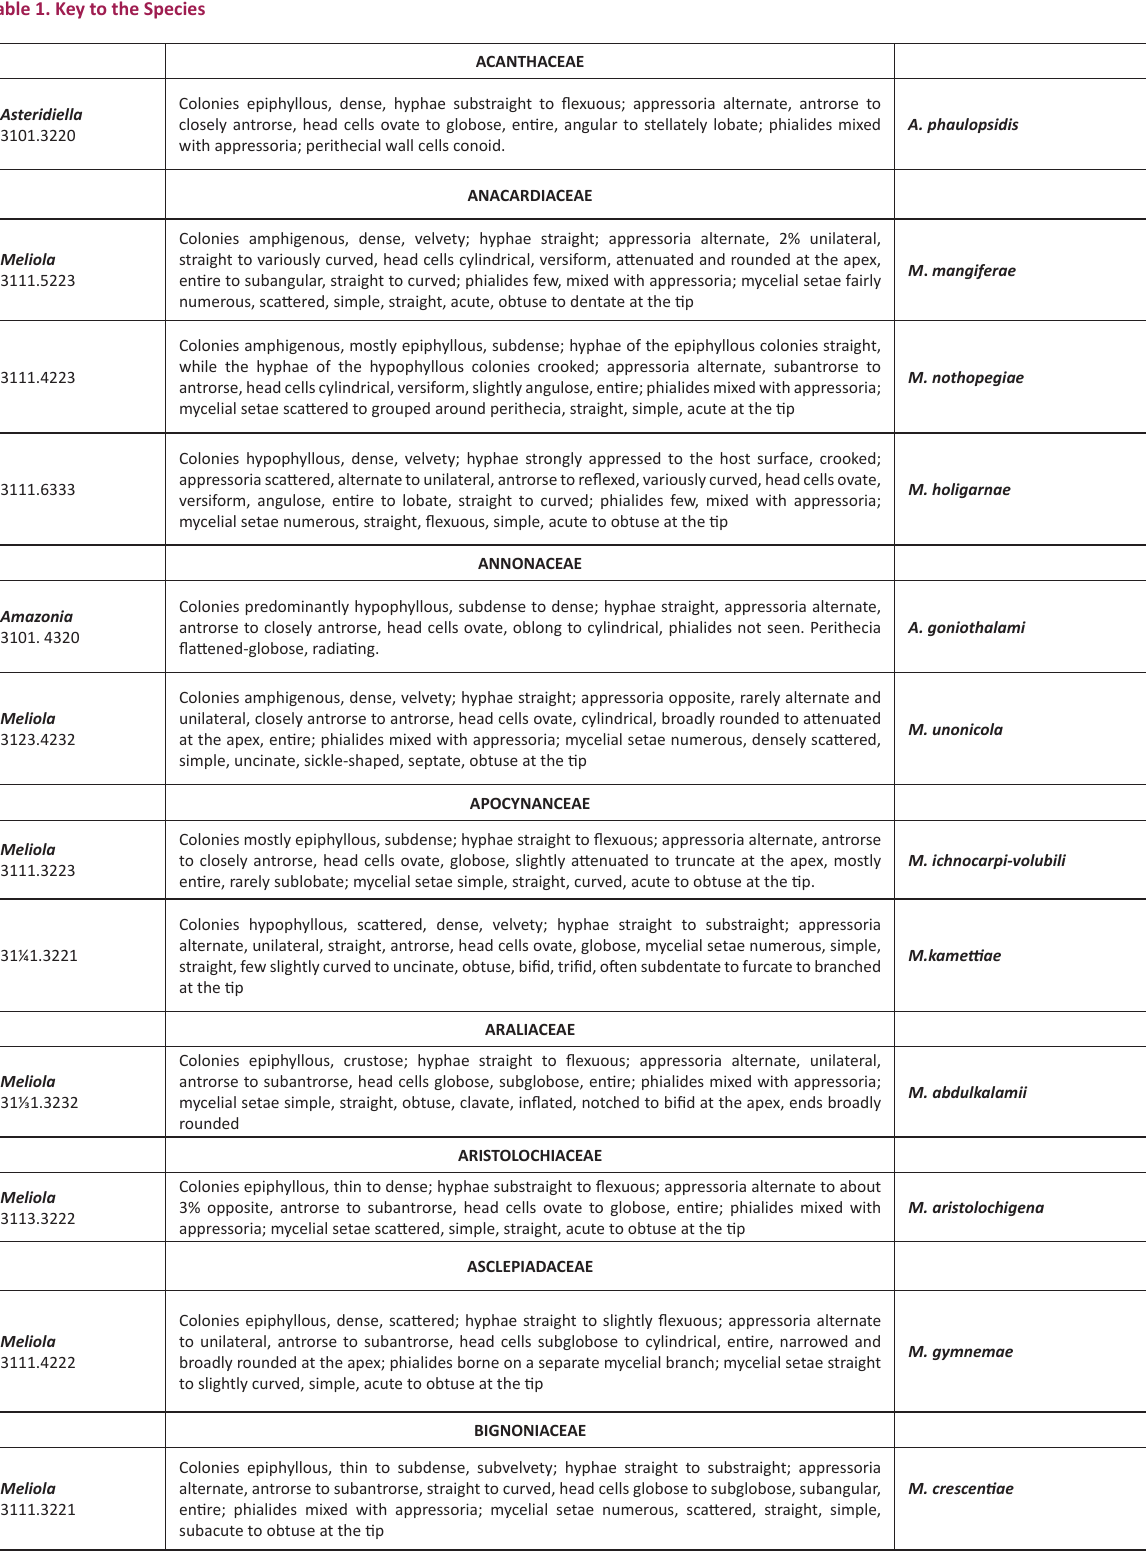
Table 1. Key to the